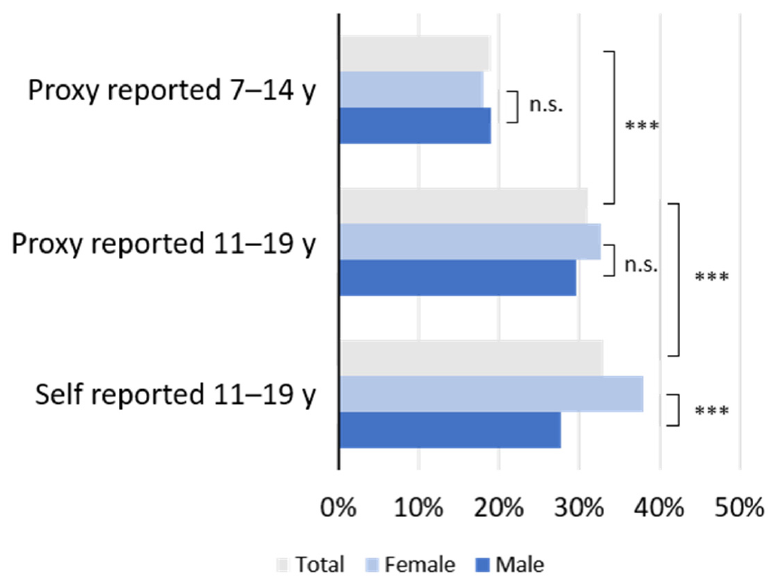
Figure 1. Prevalence of self- and parent (proxy)-reported low HRQoL in children and adolescents of COPSY South Tyrol 2021, stratified by age and gender. The x-axis represents the percentage of scholars categorized “low” by the KIDSCREEN-10 index as described in Materials and Methods.